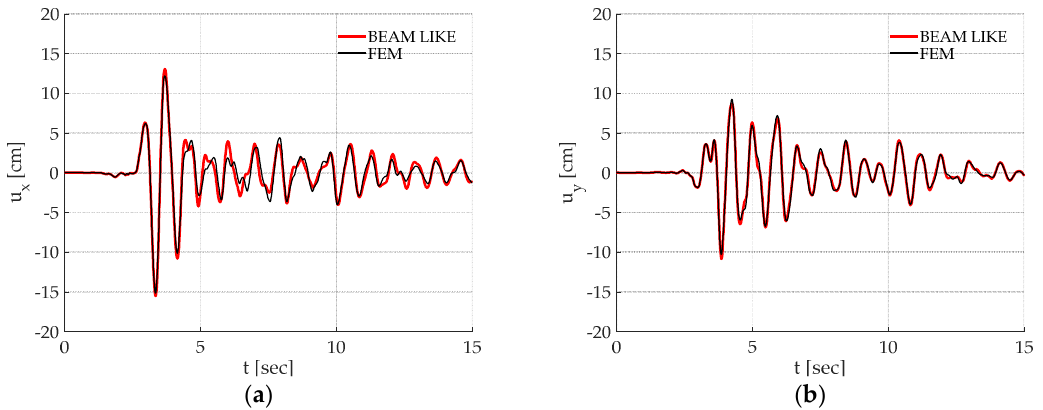
Figure 19. Six-storey benchmark. L’Aquila earthquake. Displacements time history along the ( a ) x and ( b ) y direction.